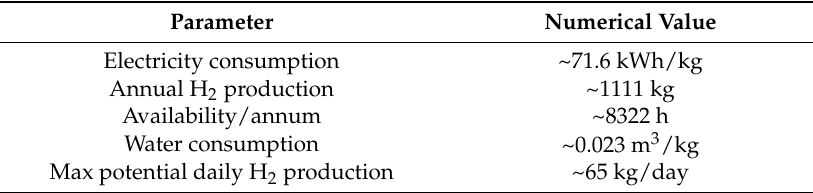
Table 4. Summary of the field data for phase 1 based on one year dataset.